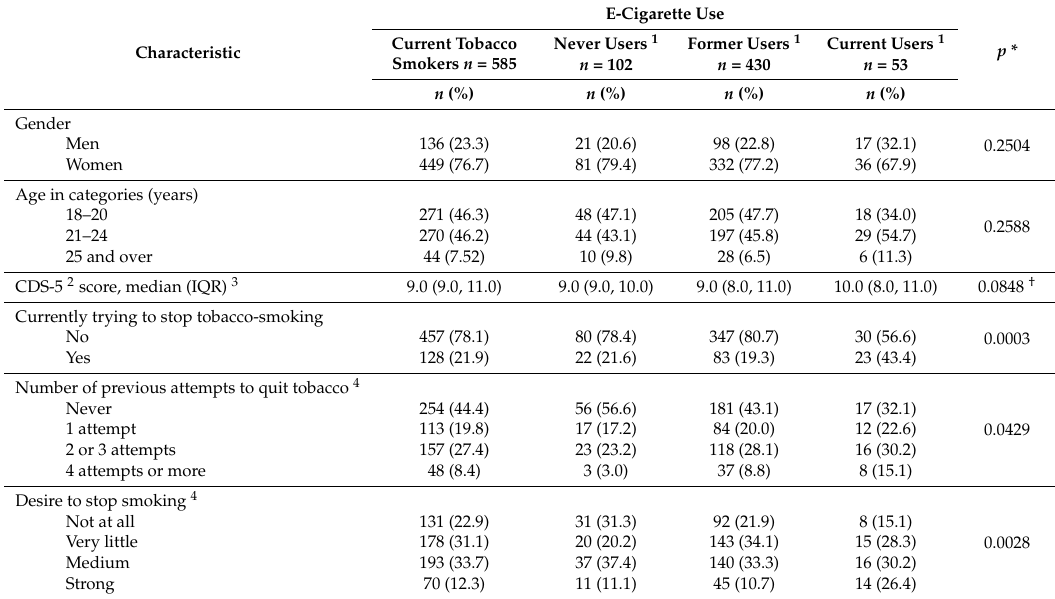
Table 5. Characteristics of “full responder” smokers according to e-cigarette